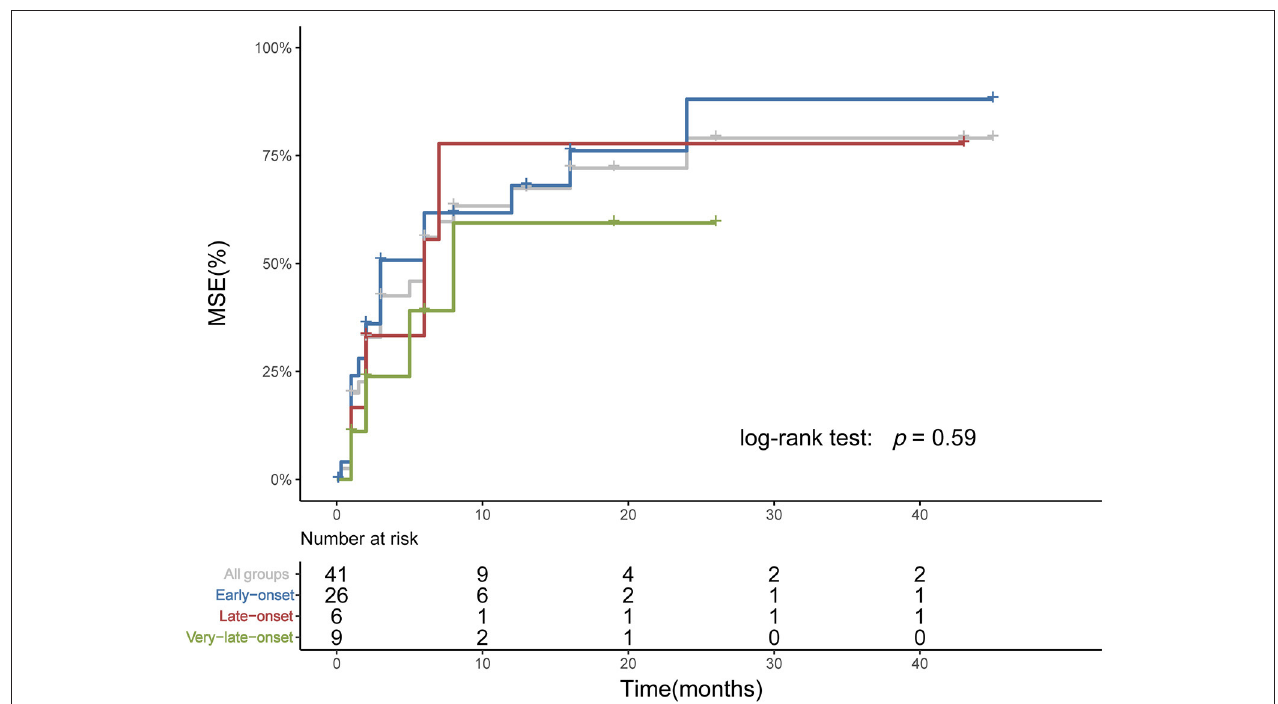
FIGURE 4 | Time from rituximab treatment to achieving MSE among subgroups. The Kaplan-Meier plot showed the time from rituximab treatment to reaching MSE. Three patients who had achieved MSE before rituximab and two patients from Xian Gaoxin Hospital with distinct regimen were not included. No significant difference was identified among